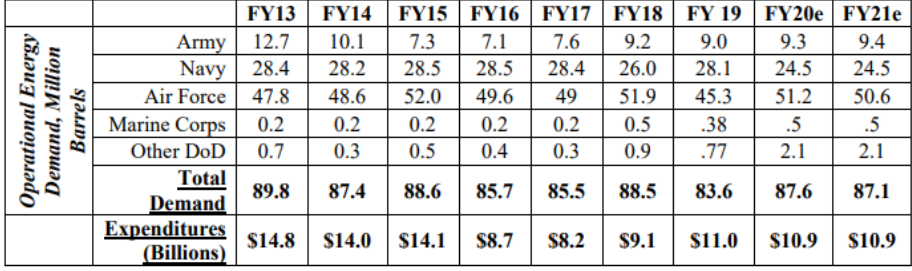
Figure 2. DoD operational energy demand by service, source: